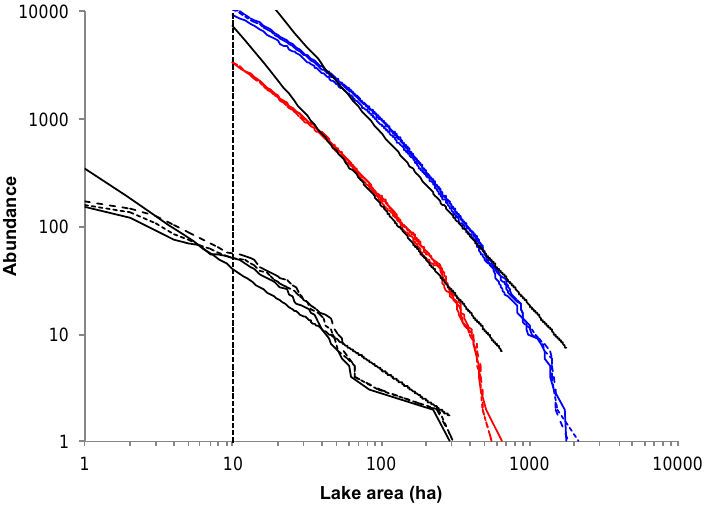
Figure 5. Log-abundance log-size plot for lakes in Nadym and Pur river basins with lower (10 ha) resolution, and 7129 sub-basin with higher (1 ha) resolution. For comparison, the figure also shows fitted power law functions (lines on log-log plot with slopes